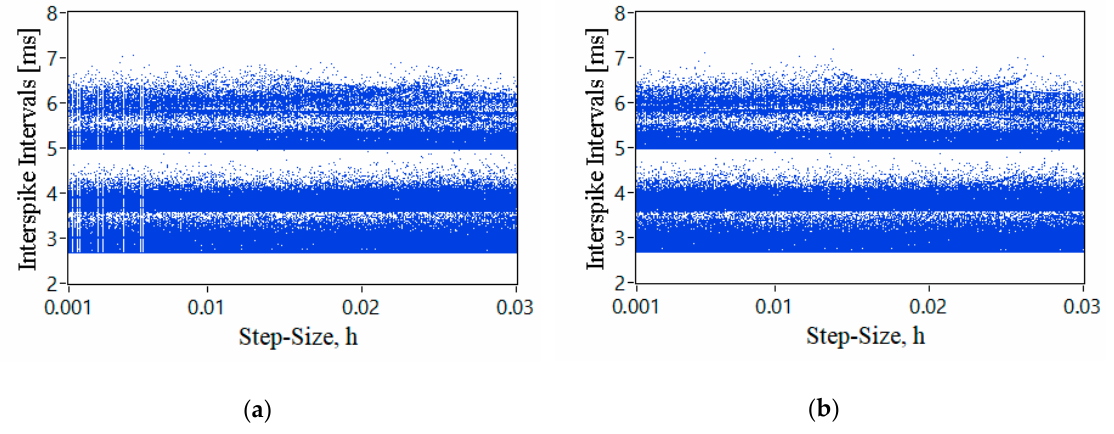
Figure 11. h-diagrams for system (1) built with EMP solvers: ( а ) 32-bit FXP, ( b ) DBL, and 64-bit FXP.